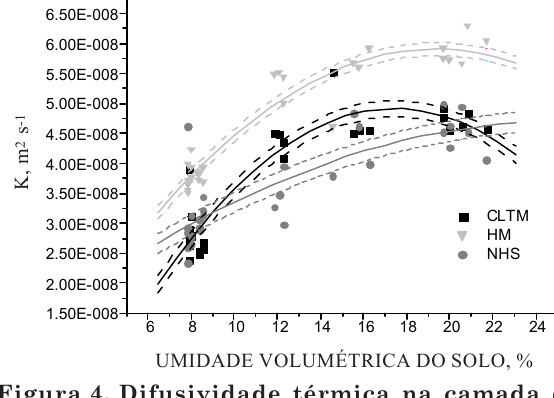
figuras 4 a 6. Em cada gráfico, os resultados dos três métodos são apresentados (Quadro 1): Valores médios e o desvio-padrão do EQM foram calculados para os métodos HM e CLTM em cada camada considerada.